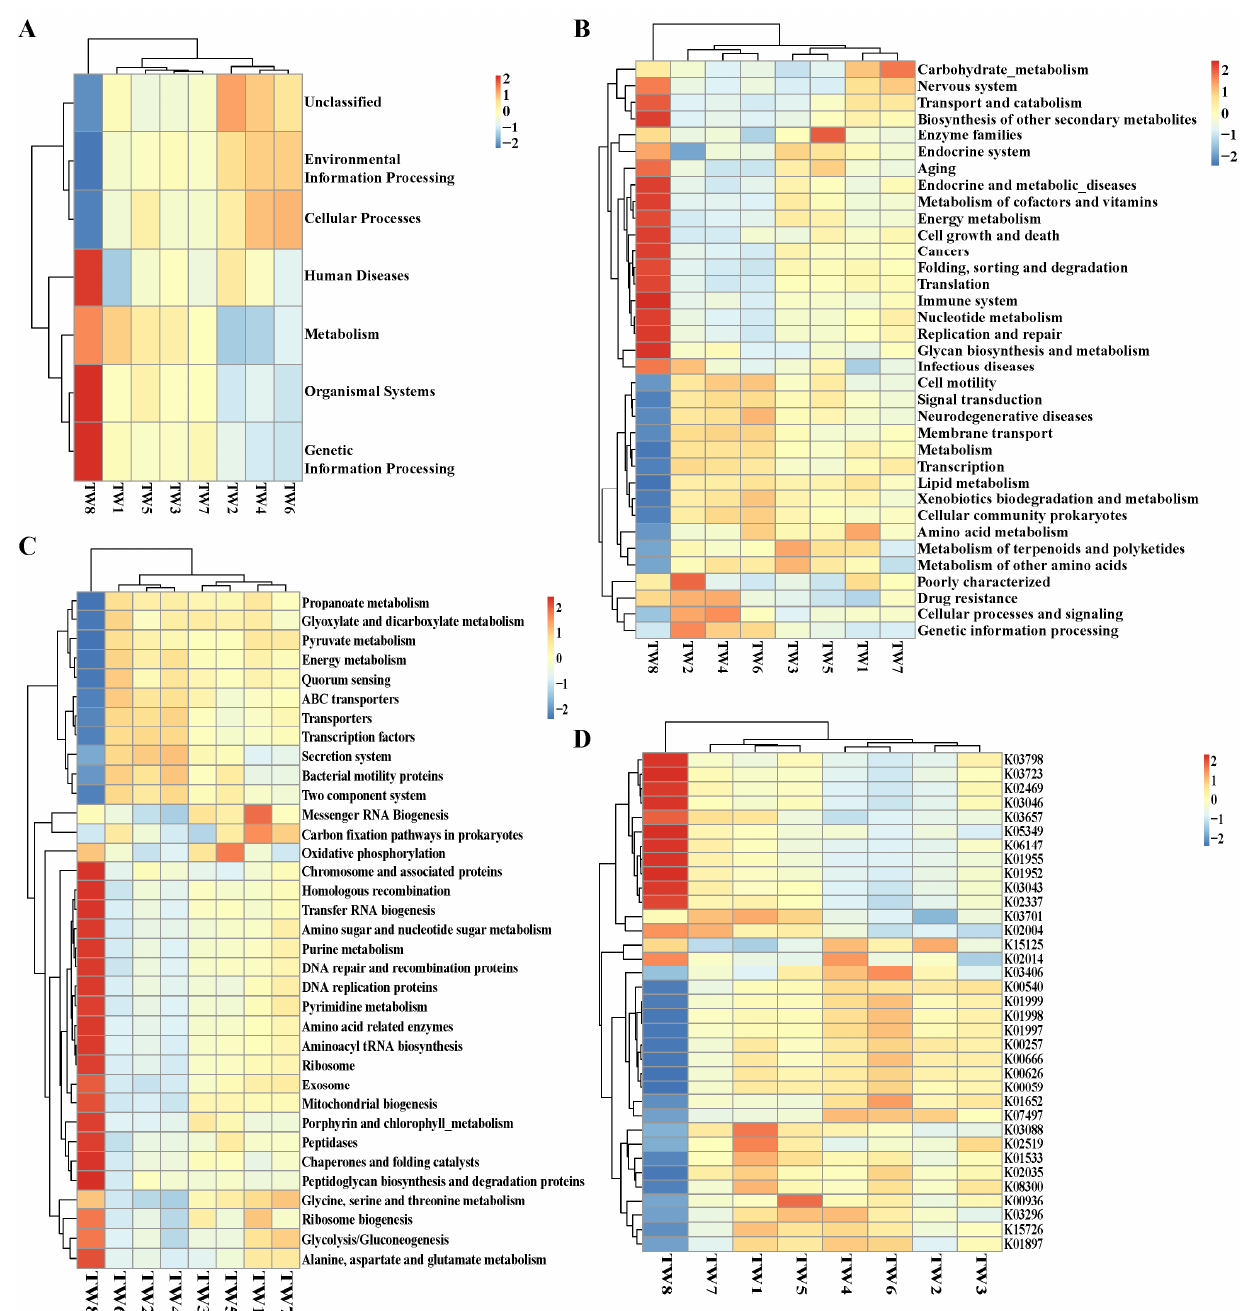
Figure 6. Predicted functions. ( A – D ) Clustering heat map of functional differences at level 1, level 2, level 3, and level